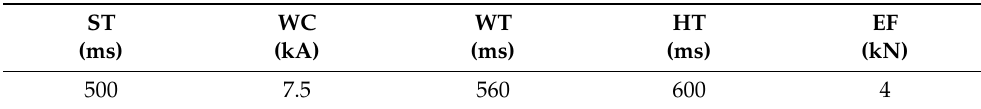
Table 3. Parameters and their levels for DPW scheme. (Reprinted from [26] with permission from Elsevier)